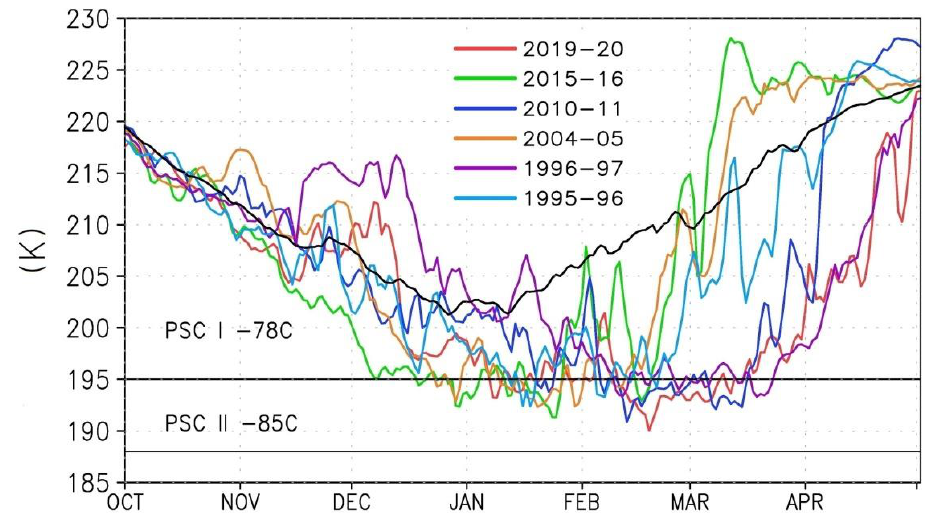
Figure 2. Minimum temperature in the region of 70–90° N at 70 hPa in October–April 1995–1996, 1996–97, 2004–2005, 2010–2011, 2015–2016, and 2019–2020. Black line corresponds to climatological mean over 1981–2010.